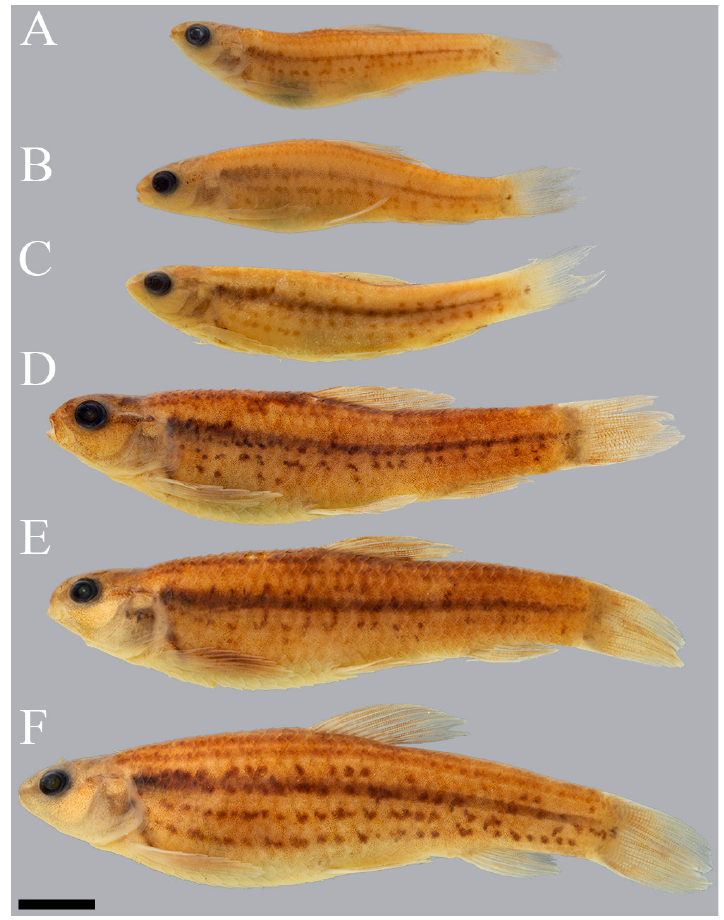
FIGURE 2 | Paratypes of Characidium onca . A – B . MZUSP 125798, 23.8–27.0 mm SL respectively, córrego Taquara; C . MZUSP 125795, 28.6 mm SL, córrego Roncador; D . ZUEC 17242, 38.7 mm SL, córrego Roncador; E – F . MZUSP 125797, 39.0–44.1 mm SL, respectively, córrego Roncador. Scale bar = 5